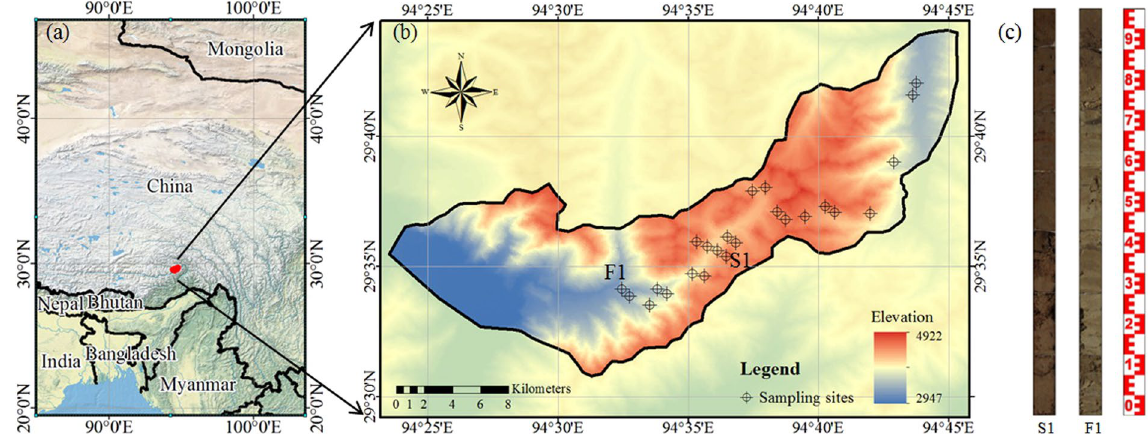
Figure 6. Location of the study area ( a ), soil core sites ( b ) and representative soil cores ( c ). S1 was the soil core in the shrub meadow and F1 in the forest. The map was created using ArcGIS 10.2 (Environmental Systems Research Institute Inc. Redlands, California, USA), of which web set was